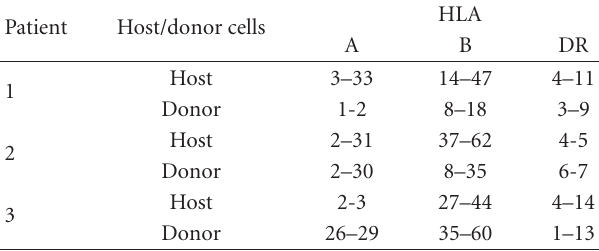
Table 1: HLA phenotypes of host cells and of cells of donor origin found in three chimeric